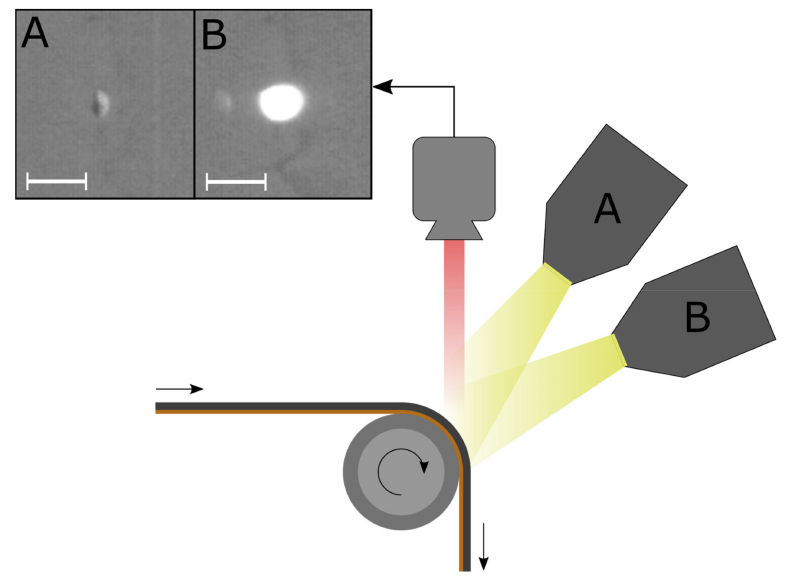
Figure 1. Measurement setup of the optical detection system with a camera and two lights in different angles to the camera. LED A and B are turned on alternatingly allowing for simultaneous detection with scattered light (LED A turned on) and direct reflection (LED B turned on). The scale shown represents 1